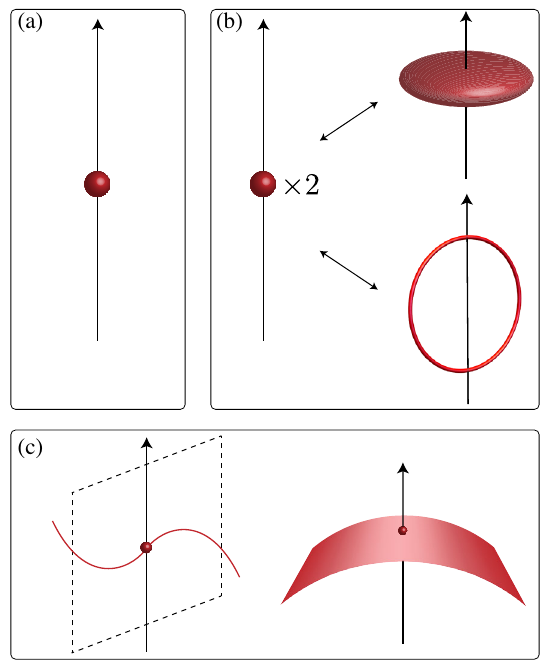
FIG. 3. Illustration of results of gapless point classifications on a line: (a) The gapless point on the line is a genuine point node. (b) A point node formed by multiple gapless points can be realized, but such a point node is actually a shrunk loop or surface node. Since there are no reasons why two gapless points are at the same position, it is natural to consider that a shrunk loop or surface node exists in such a case. (c) The gapless point must be part of a line or surface